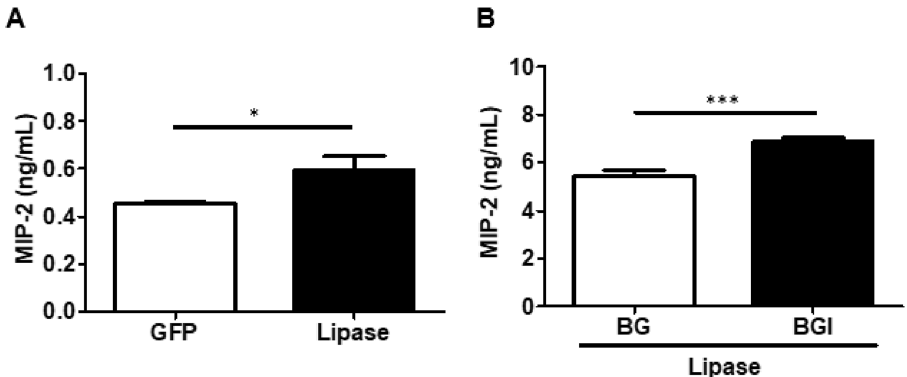
Figure 4. MIP-2 expression through electron treatment in mice ears after lipase injection. ( A ) MIP-2 expression (ng/mL) after lipase induction. ( B ) MIP-2 expression (ng/mL) in mouse ears of B. circulans with glucose in the absence (BG) or presence (BGI) of roseoflavin. Data are expressed as the mean ± SD from three separate experiments. * p < 0.05 and *** p <